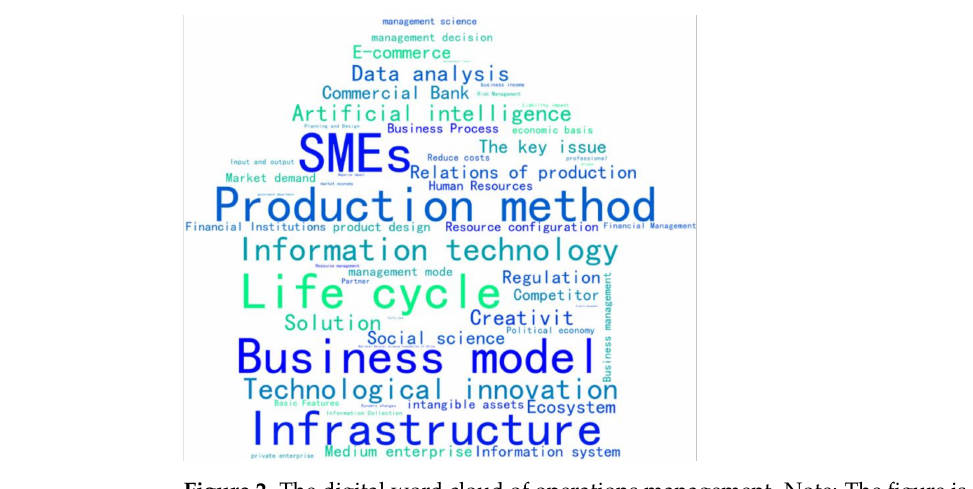
Figure 2. The digital word cloud of operations management. Note: The figure is drawn based on the results of web crawlers with Python 3.10.0.